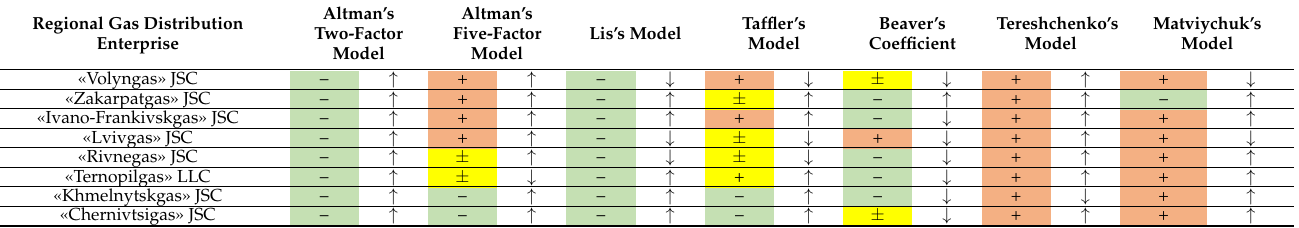
Table 11. Generalized value indicator of bankrupt contingency of gas distribution companies in the western region of